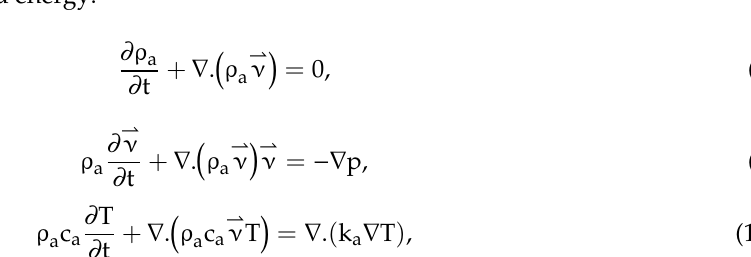
discharging rates: ( a ) voltage and ( b ) maximum temperature.